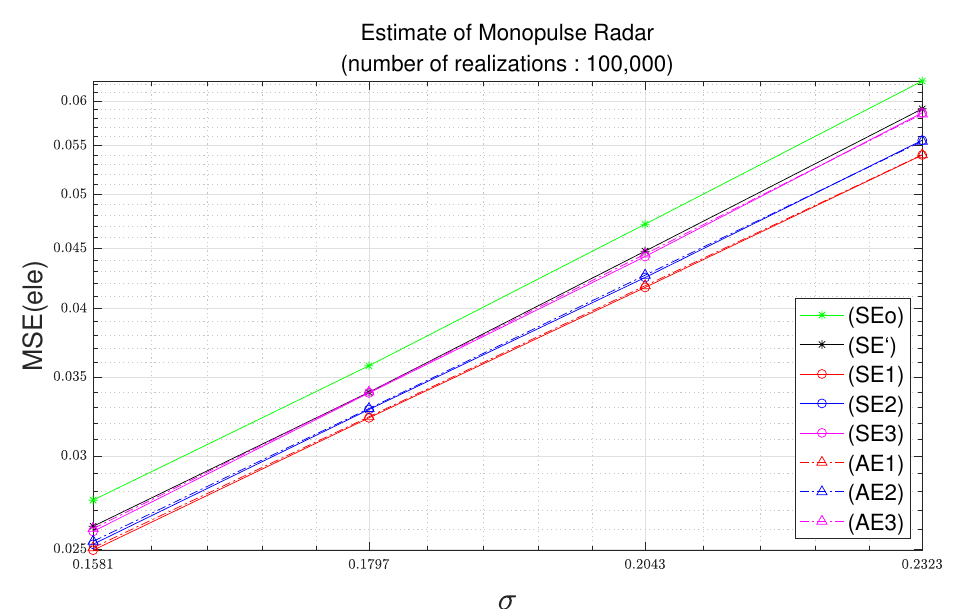
Figure 8. Elevation MSE as function of standard deviation with parameters of Table 3 and 100,000 realizations.